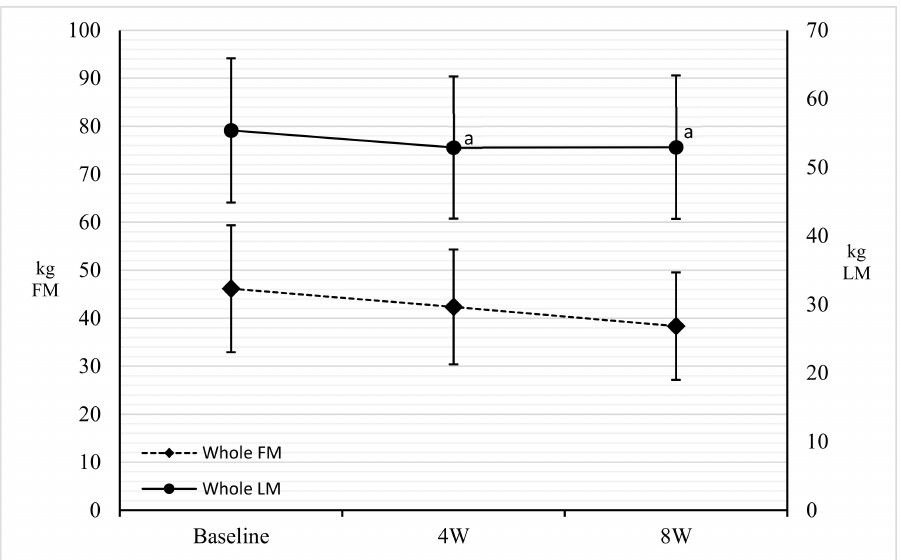
Figure 2. Comparison among baseline, four weeks, and eight weeks for whole FM and whole LM. Points sharing the same superscript letter are not significantly di ff erent from each other. Statistical significance attributed to results with p < 0.05. FM: Fat Mass; LM: Lean Mass; ECW: Extra Cellular Water; BCM: Body Cell Mass; 4W: 4 weeks; 8W: 8